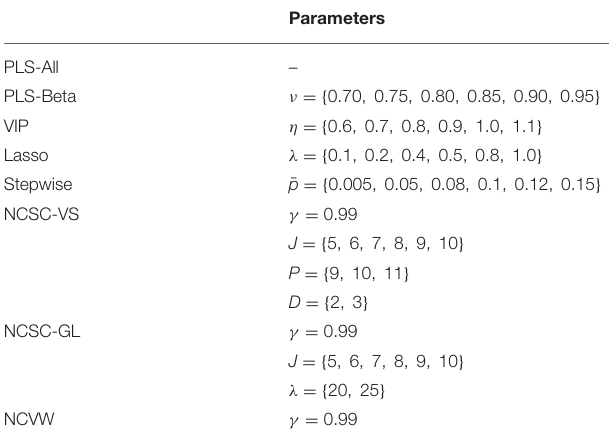
TABLE 1 | Tested parameters.